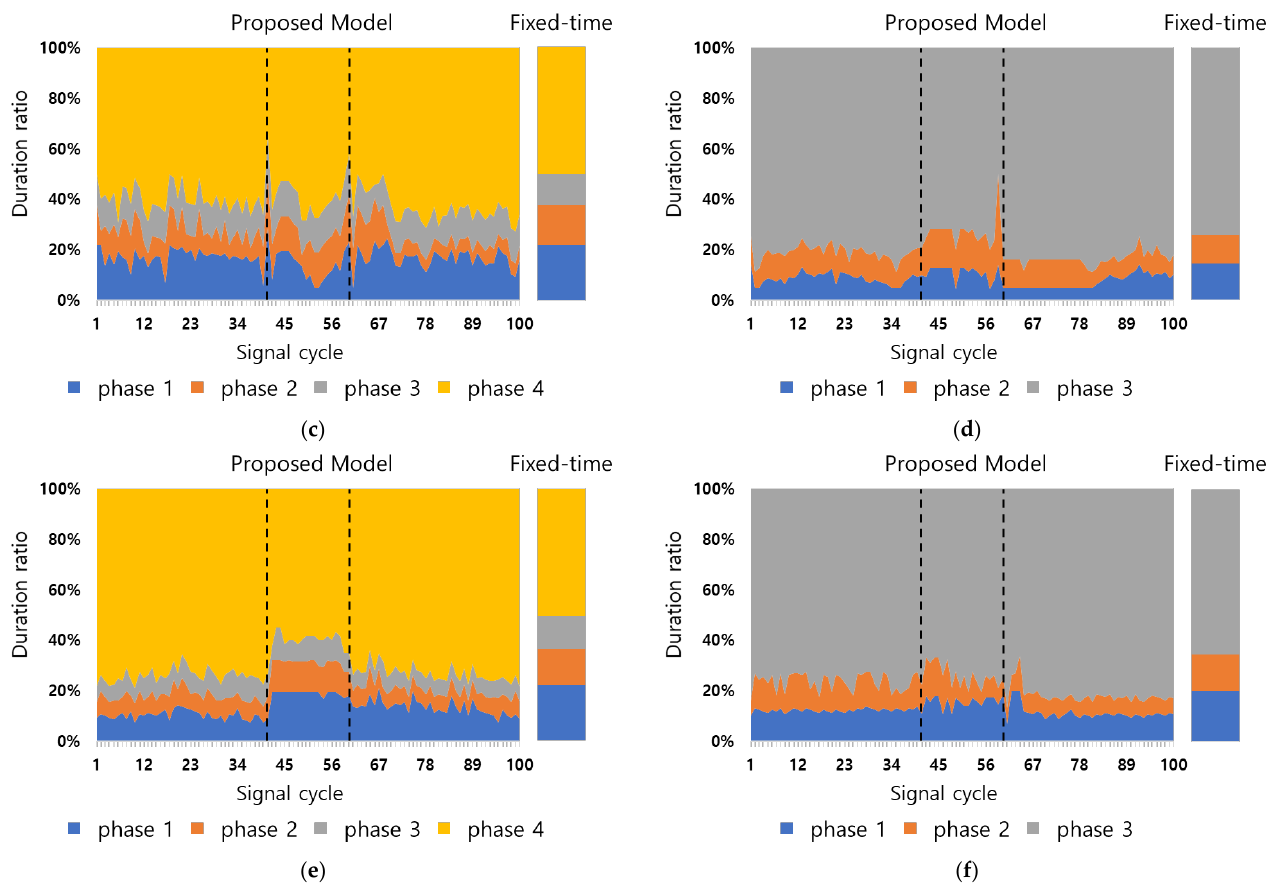
Figure 6. Phase duration ratio of scenario 2: ( a ) Intersection 1; ( b ) Intersection 2; ( c ) Intersection 3; ( d ) Intersection 4; ( e ) Intersection 5; and ( f ) Intersection 6. The time point at which the cycle length changes is indicated by a dotted line. The first cycle length is 160 s and changes to 180 s after the first dotted line, and then changes back to 160 s after the second dotted line.